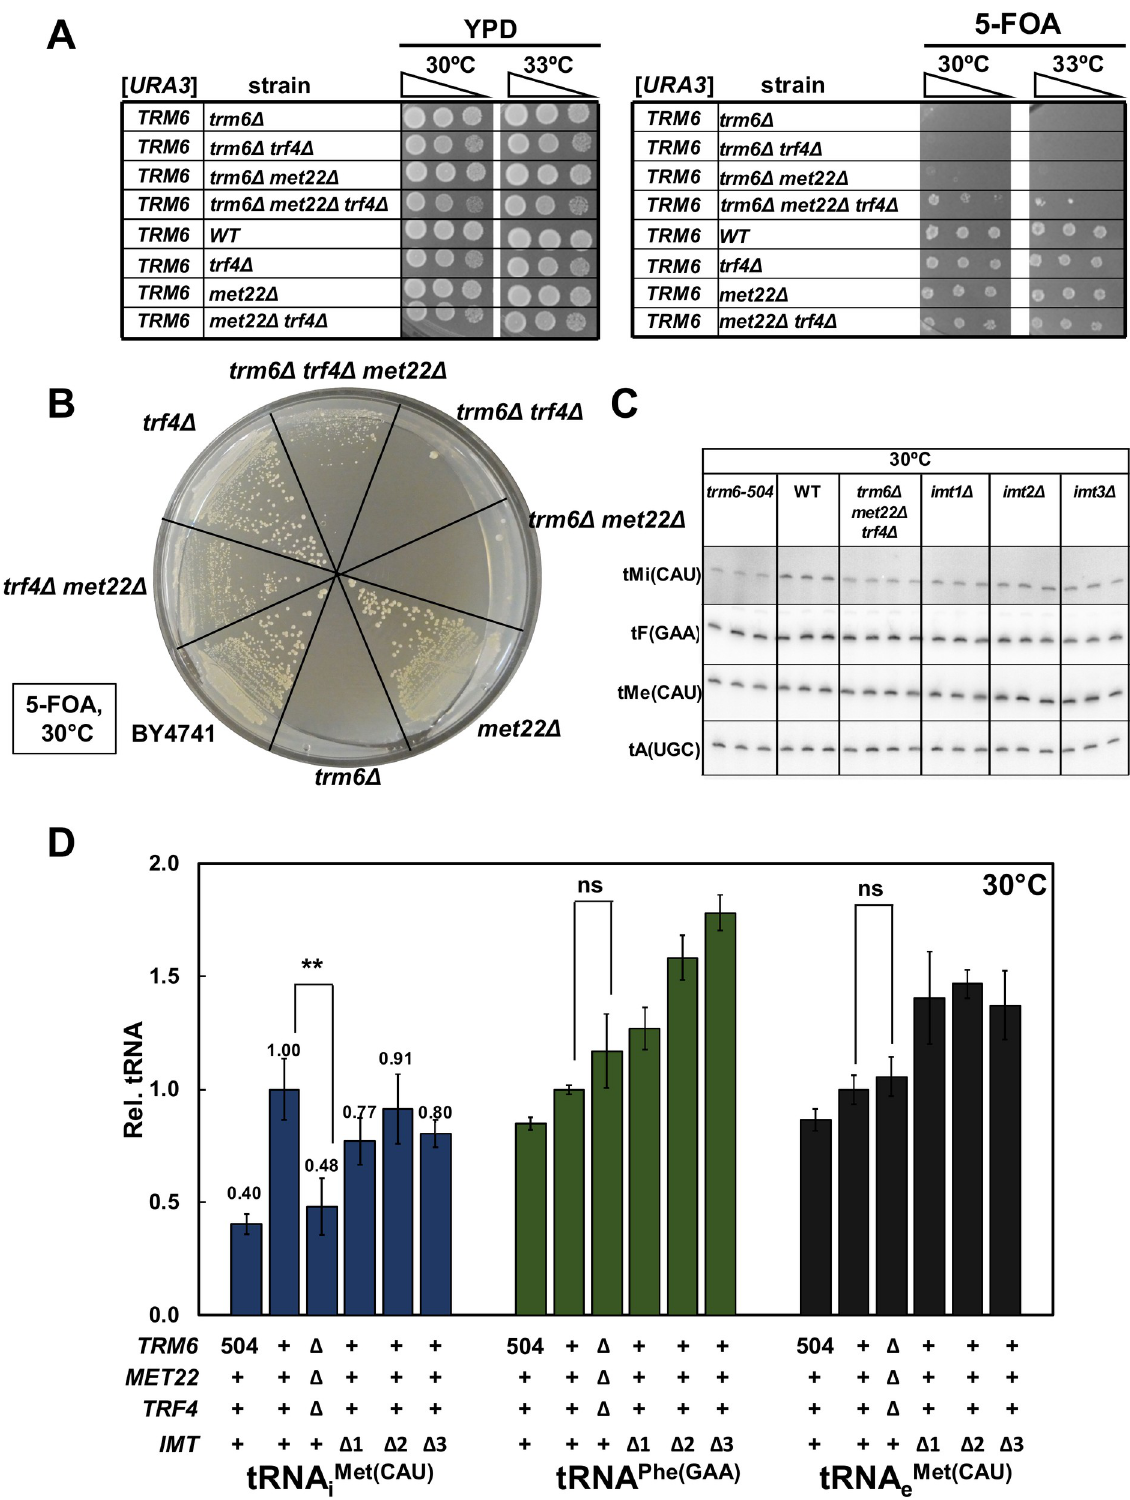
Fig 8. The lethality of an S . cerevisiae trm6 Δ mutant is suppressed by deletion of both MET22 and TRF4 , but not by either deletion alone, and results in modest tRNA iMet(CAU) levels. (A) Growth test on plates of an S . cerevisiae trm6 Δ [ URA3 TRM6 ] strain with a met22 Δ and/ or trf4 Δ mutation. Strains were grown overnight in YPD media at 30˚C, diluted to OD 600 ~3, serially diluted 10-fold in water, and 2 μ L were